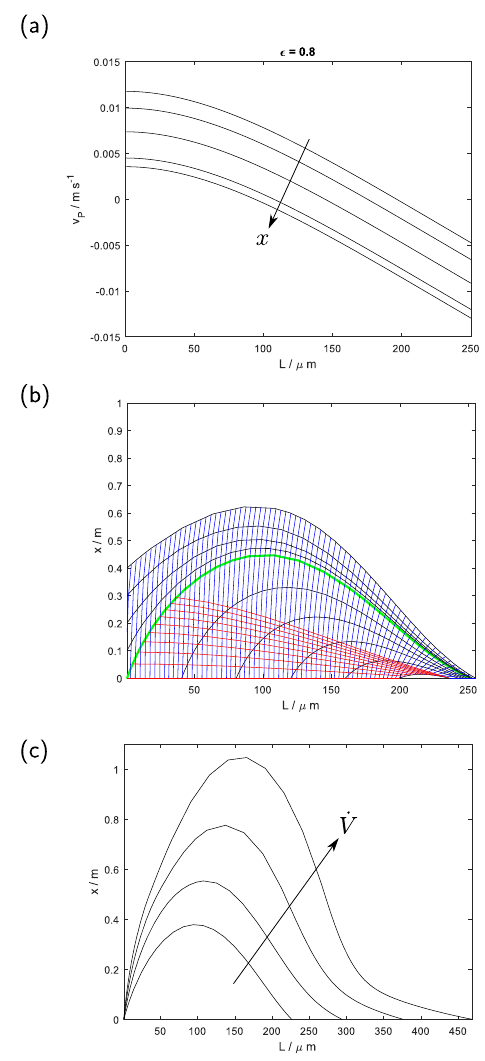
Figure 9. Results of the linear model with the particle velocity approach by Richardson and Zaki; ( a ) particle velocity as a function of the particle size at different positions x in the crystallizer; ( b ) characteristics of the linear model; blue curves indicate points reaching the mill at the same time; red curves indicate points having left the mill at the same time; ( c ) characteristic through ( L min , x min ) for different liquid flow